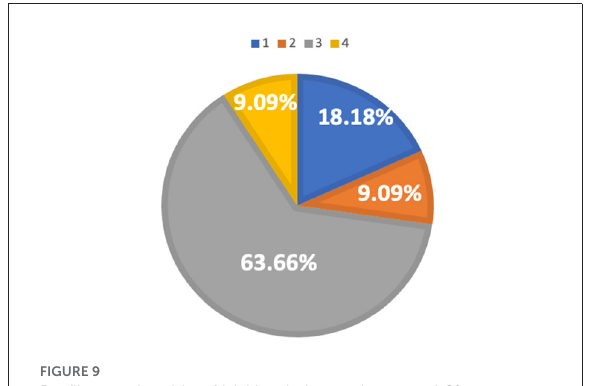
FIGURE6 Profile membership of L1 Hindi speakers rated 50.